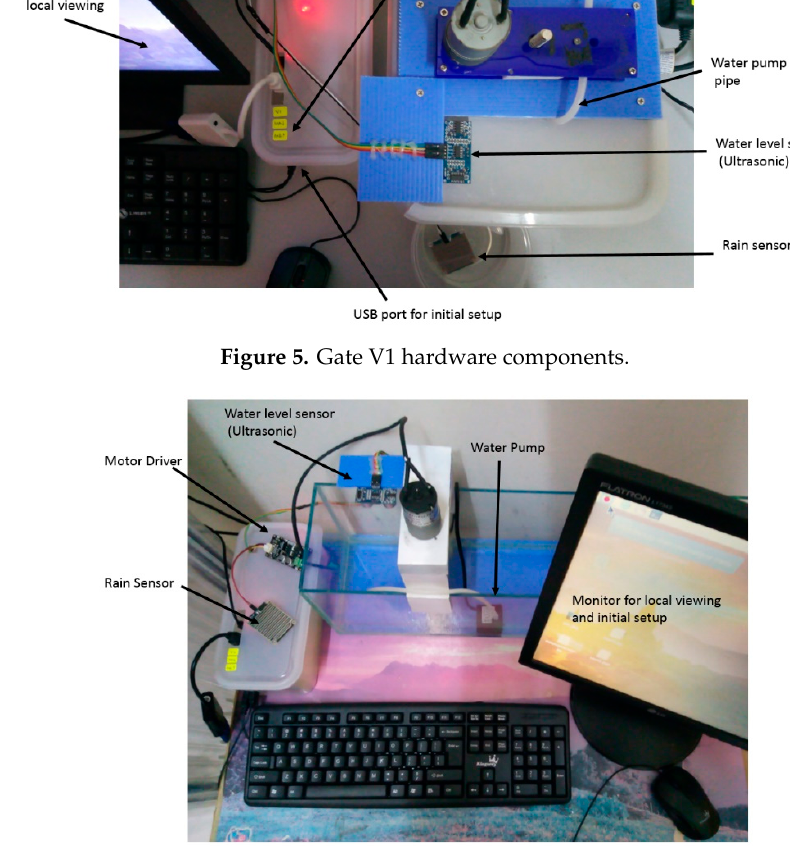
Figure 6. Gate V2 hardware components.